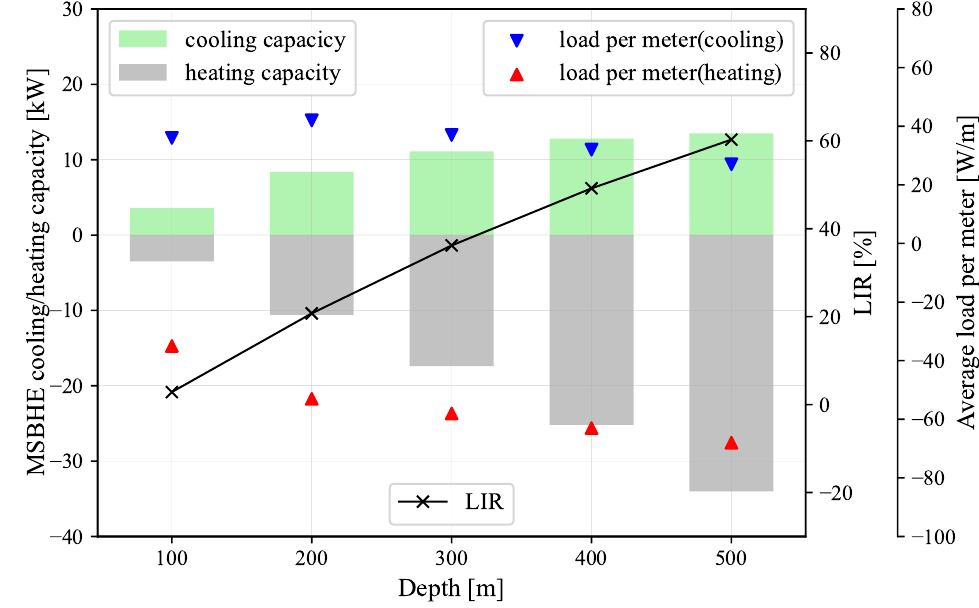
Figure 4. Maximum cooling and heating load of MSBHE and LIR under different